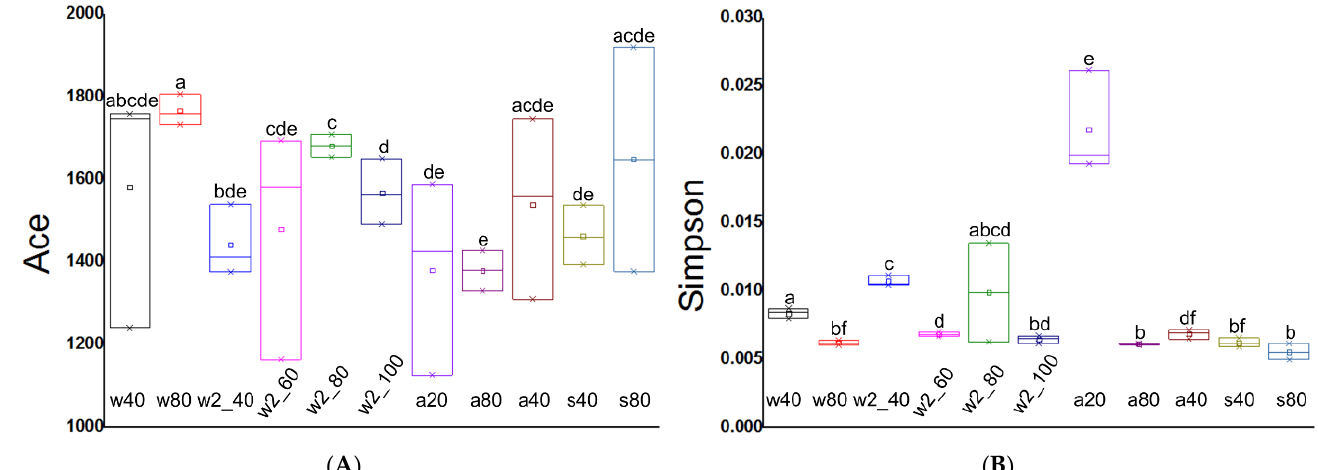
Figure 3. Alpha diversity variations among soil samples under various moisture regimes. ( A ) Com- munity richness represented by Ace; ( B ) Community diversity represented by Simpson index. Boxes represent 25 – 75% of the data, middle lines the median, and the small boxes inside represent the average values. Means that do not share a letter are significantly different. a20, 20% WHC for one week; a80, 80% WHC for two weeks; a40, 40% WHC for two weeks; w40, 40% WHC for two weeks; w80, 80% WHC for two weeks; s40, 40% WHC for four weeks; s80, 80% WHC for four weeks; w2_40, 40% WHC for one week; w2_60, 60% WHC for one week; w2_80, 80% WHC for one week; w2_100, 100% WHC for one week.